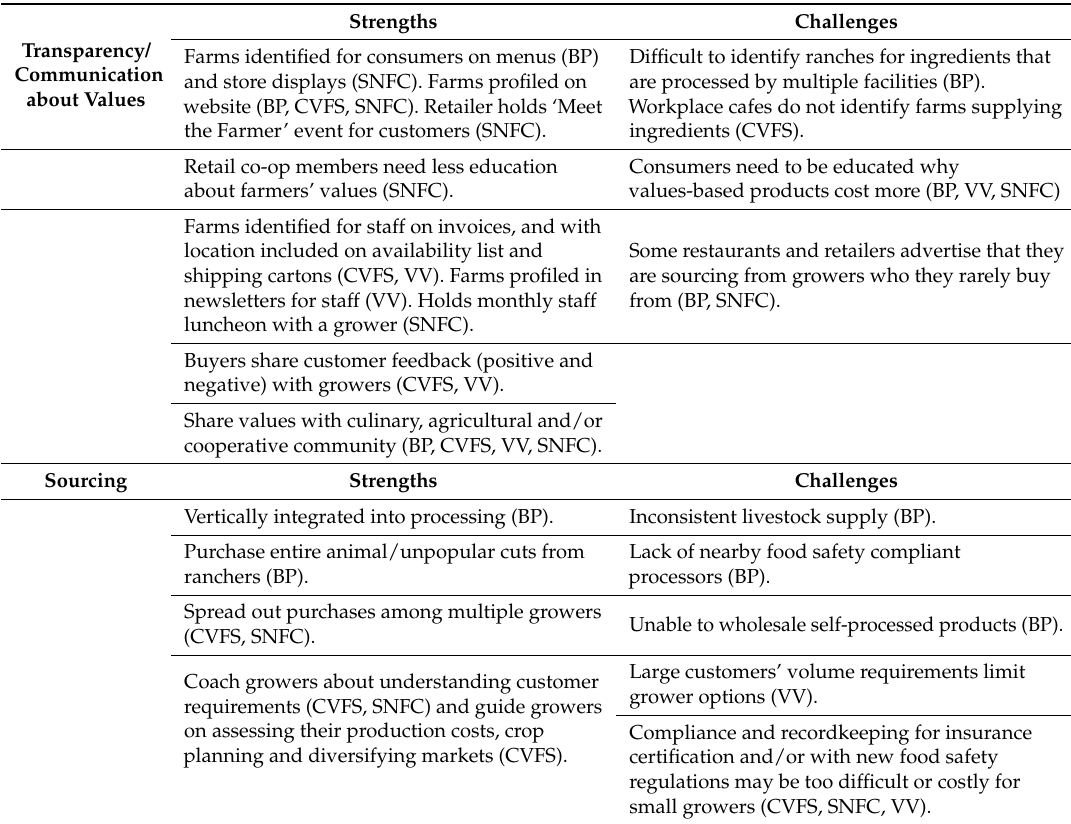
Table 1. Strengths and challenges of values-based supply chains 1